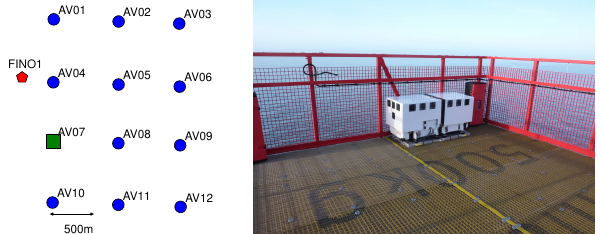
Figure 4. Measurement system installation at alpha ventus. Left panel: layout of alpha ventus wind farm and position of FINO1 me- teorological mast. Right panel: photography of installation of Wind- cube plus scanner at helicopter deck of the Adwen’s AD5-116.